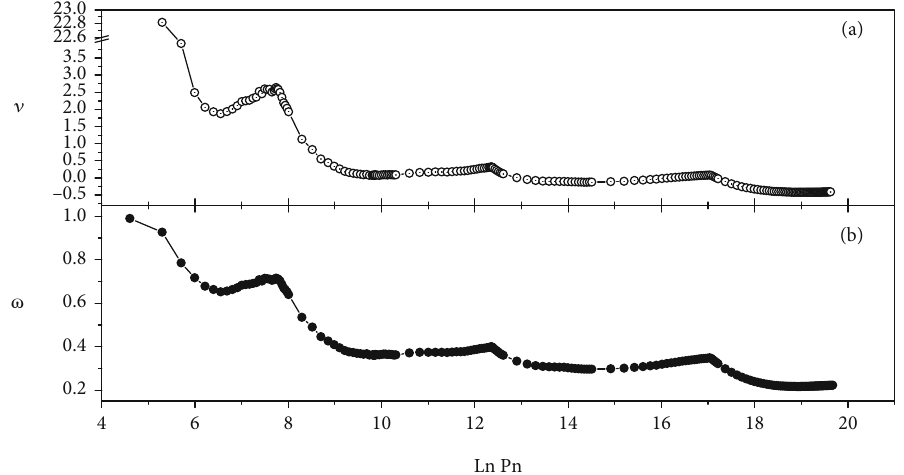
Figure 7: (a) The relation between the natural logarithm of the accumulated prime numbers from 200 to 350 million primes and the inverse χ 2 parameter ν . (b) The relation between the natural logarithm of the accumulated prime numbers from 100 to 350 million primes and the Brody parameter ω